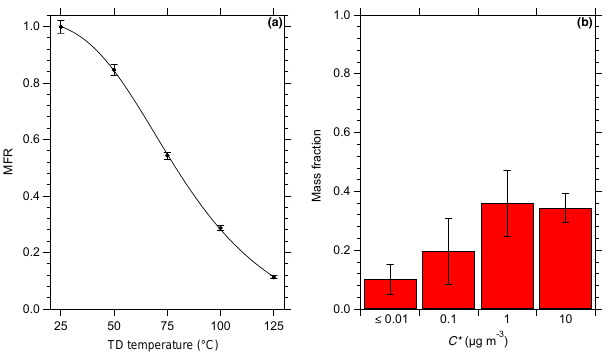
Figure 2. (a) The thermogram for ammonium sulfate aerosol. (b) The calculated activation diameter at three CCNC supersatu- rations for the BP (red), two TD temperatures (green and blue), and Köhler theory (black) for ammonium sulfate aerosol. The error bars represent 1 standard deviation of the mean. Table 1. Description of experimental conditions used in this study. Exp.